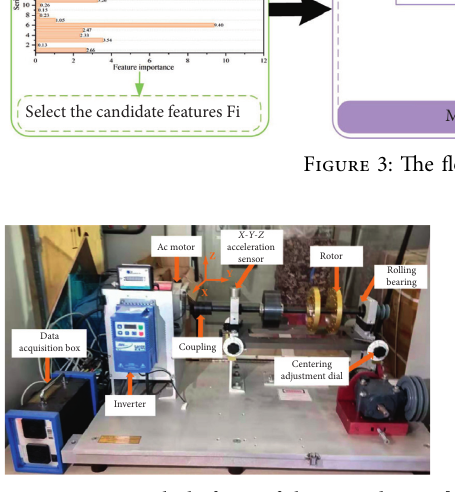
Figure 4: Experimental platform of the MFS dataset [54]. Table 1: Details of ten types of faults.